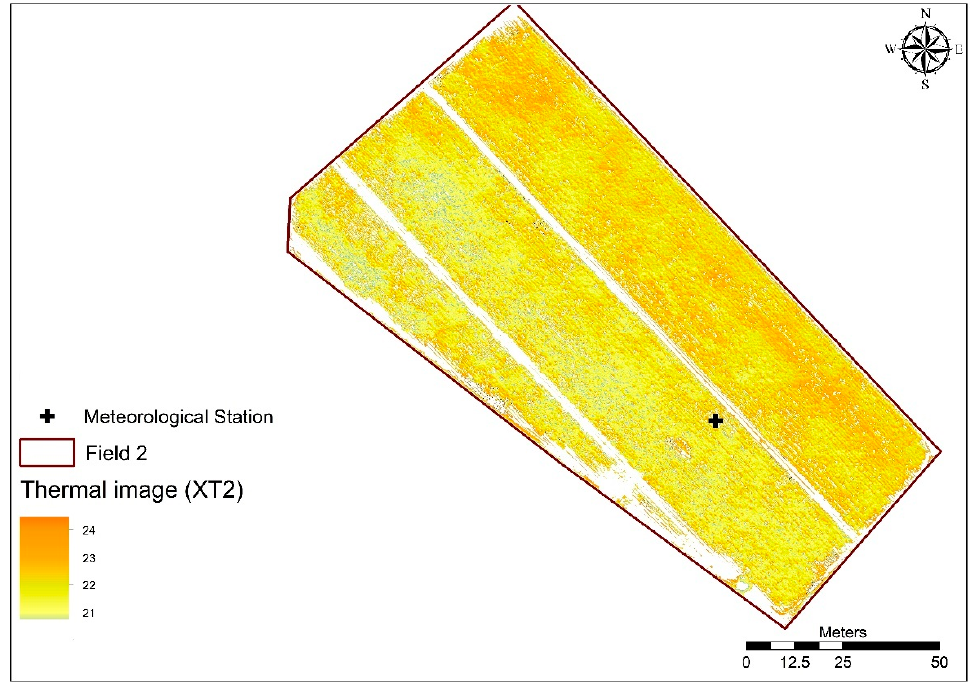
Figure 15. Thermal image acquired by the Zenmuse XT2 camera showing only the crop vegetation’s temperature values by masking all the non-vegetation pixels.